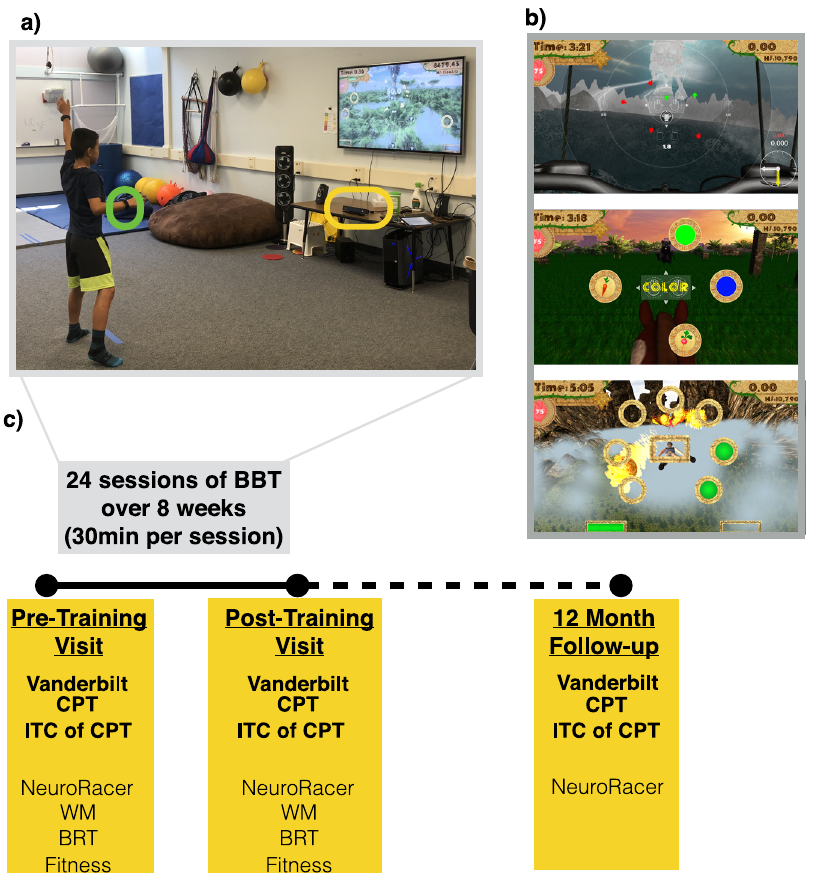
Fig. 1 BBT platform. a Image of participant playing BBT. Highlighted is the use of a heart rate monitor (green circle; used to assess and adapt the physical intensity of game play in real-time) and the Microsoft Kinect ™ motion capture technology (yellow circle; used to collect responses with one ’ s hands and/or feet based on the cognitive task presented on the monitor and adapt the cognitive dif fi culty of each game in real- time). b Image of the three modules in BBT, with the top panel showing the visual search module, the middle panel showing the task switch module, and the lower panel showing the working memory module. A video of BBT in action can be viewed at https://youtu.be/ vvR5WhSzQU4. c An overview of the study timeline with outcome measures collected at each timepoint listed. Abbreviations - CPT: Continuous Performance Task. ITC of CPT: Inter-Trial Coherence of the Continuous Performance Task. WM: Working Memory Task. BRT: Basic Response Time